Question: Generate an informative caption for the figure above.
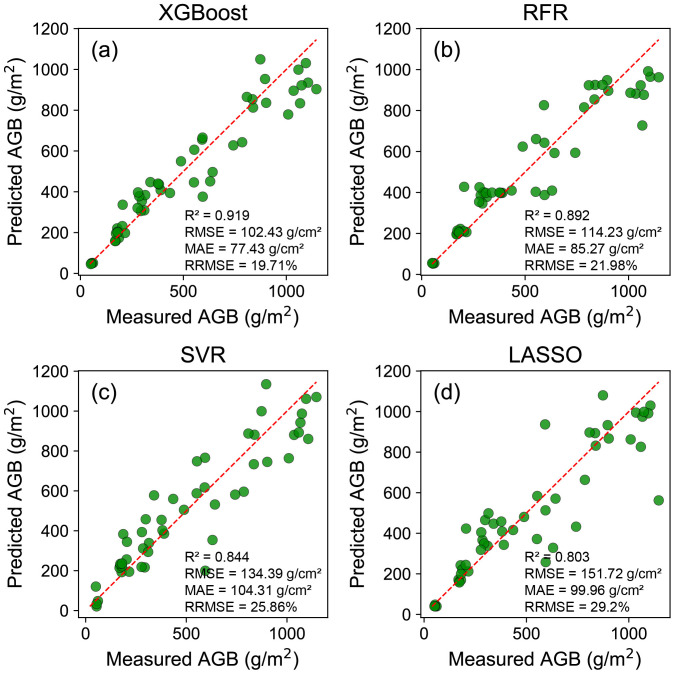
Answer: Comparison of measured and predicted wheat biomass using different machine learning models. (a) XGBoost, (b) RFR, (c) SVR, (d) LASSO.